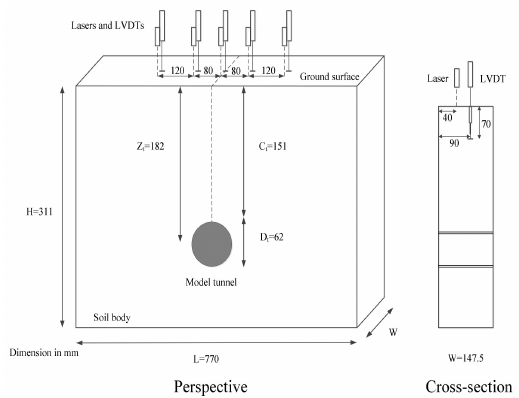
Figure 5. Centrifuge package—tunneling in sandy ground.